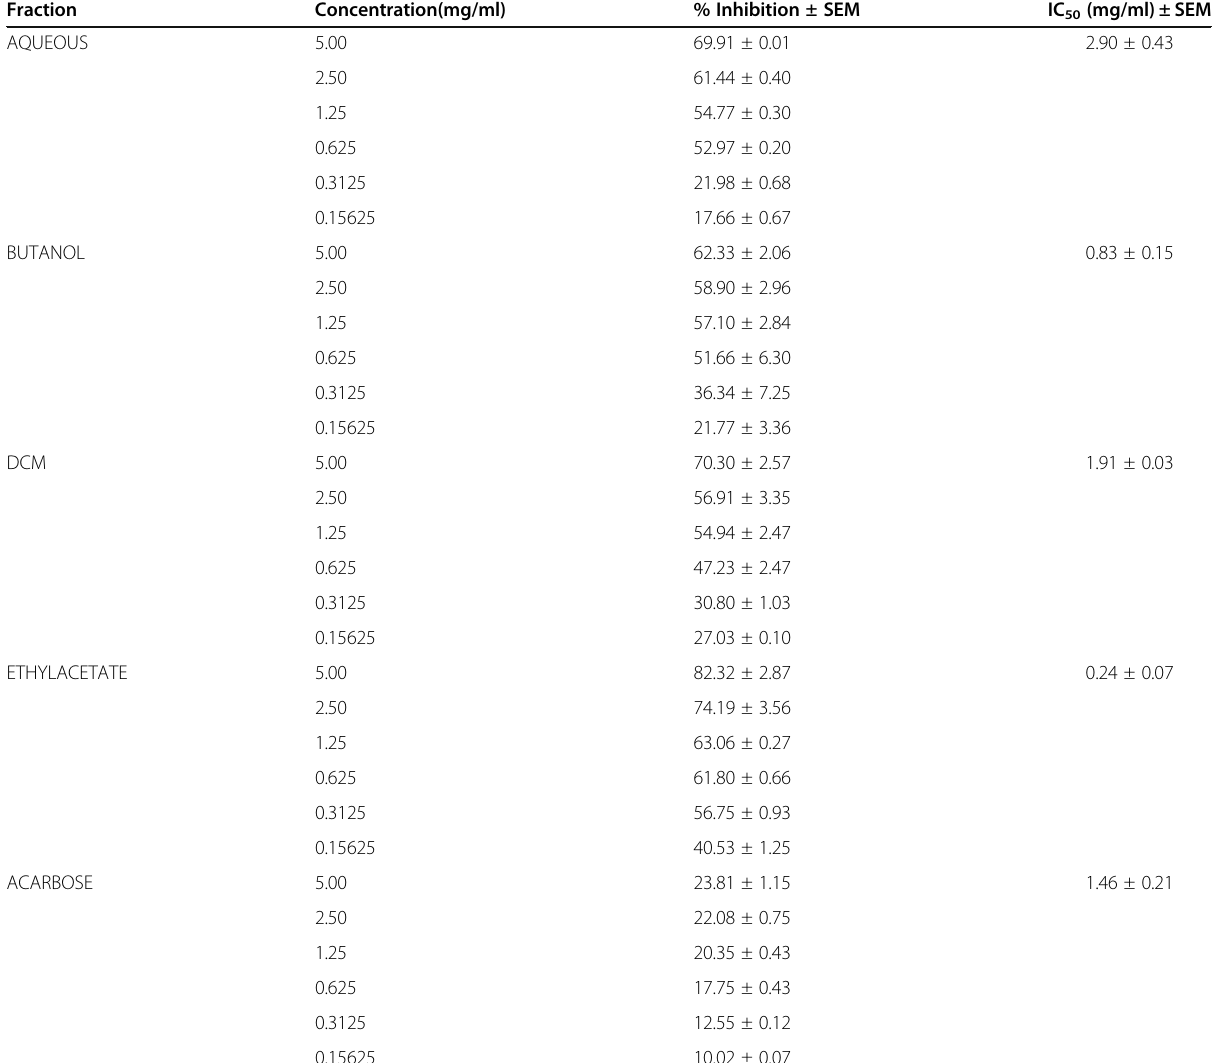
Table 3 In vitro inhibitory effects of different solvent fractions fractions of P. guineense on α - glucosidase activity